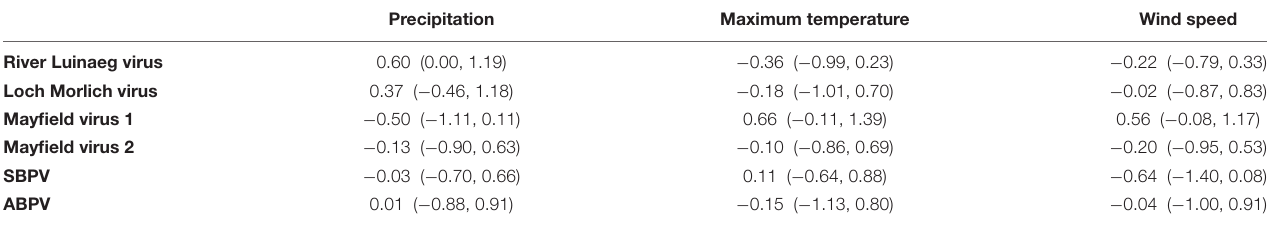
TABLE 2 | The posterior means and 90% shortest posterior intervals of the coefficients of the effect of each environmental covariate on each virus on the link scale from the multivariate probit